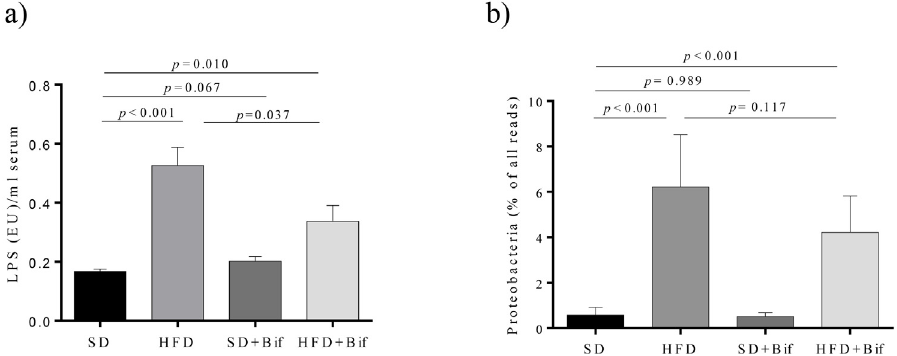
Fig 6. Lipopolysaccharide (LPS) concentration in serum(a) and Proteobacteria abundance in faeces of different mouse groups after 14 weeks of dietary intervention (b). SD group: control mice receiving a standard diet (SD) plus placebo; HFD group: obese mice receiving a high-fat diet (HFD) plus placebo; SD+Bif group: control mice receiving SD and a daily dose of 1 x 10 9 CFU B . pseudocatenulatum CECT 7765; HFD+Bif group: obese mice receiving HFD and a daily dose of 1 x 10 9 CFU B . pseudocatenulatum CECT 7765 by gavage during 14 weeks. LPS concentrations are expressed as means and standard errors (error bars) of data from each mouse group (n = 8 per group) and statistically significant differences were determined by ANOVA with Bonferroni ’ s post hoc test at p < 0.050 (a). Proteobacteria abundances as relative fractions of all 454 reads in each sample are represented as means and standard errors (error bars) of data from each mouse group (n = 8) and statistically significant differences were determined using a permutation test at a p < 0.050